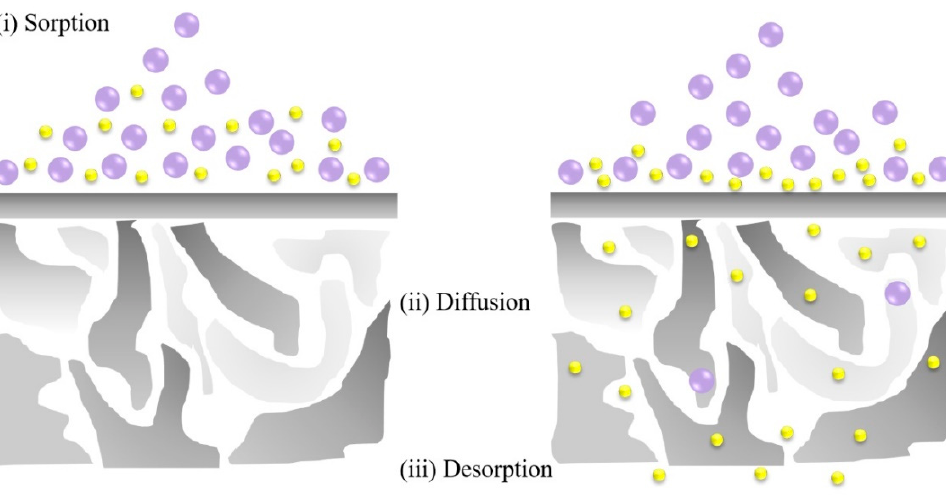
Figure 3. Graphical presentation of the solution–diffusion model.